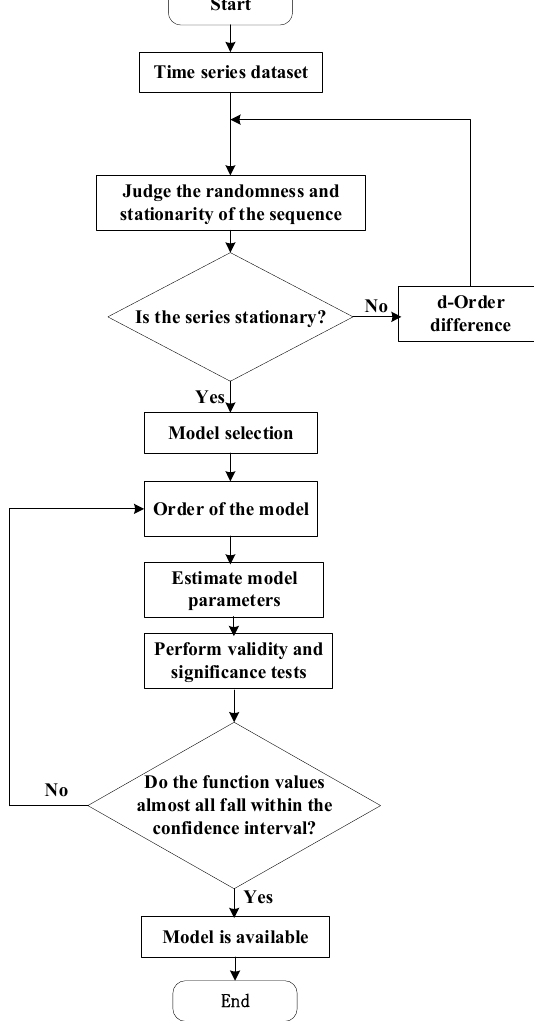
Figure 3. ARIMA model construction